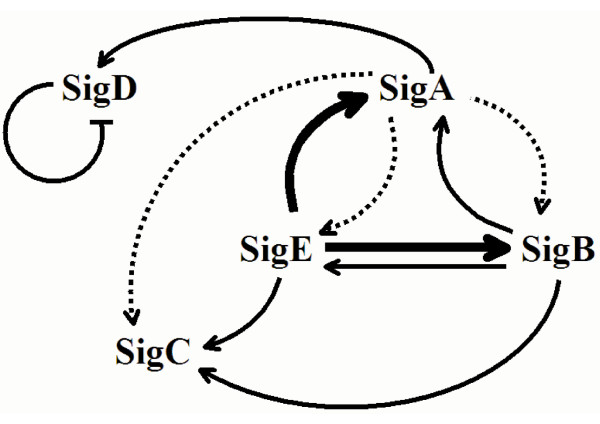
Schematic network of transcriptional interactions between group 2 sigma genes transcription in Synechocystis: The thickness of the arrows is proportional to the effect of a given mutation on the transcription of the sigma gene to which the arrow points.